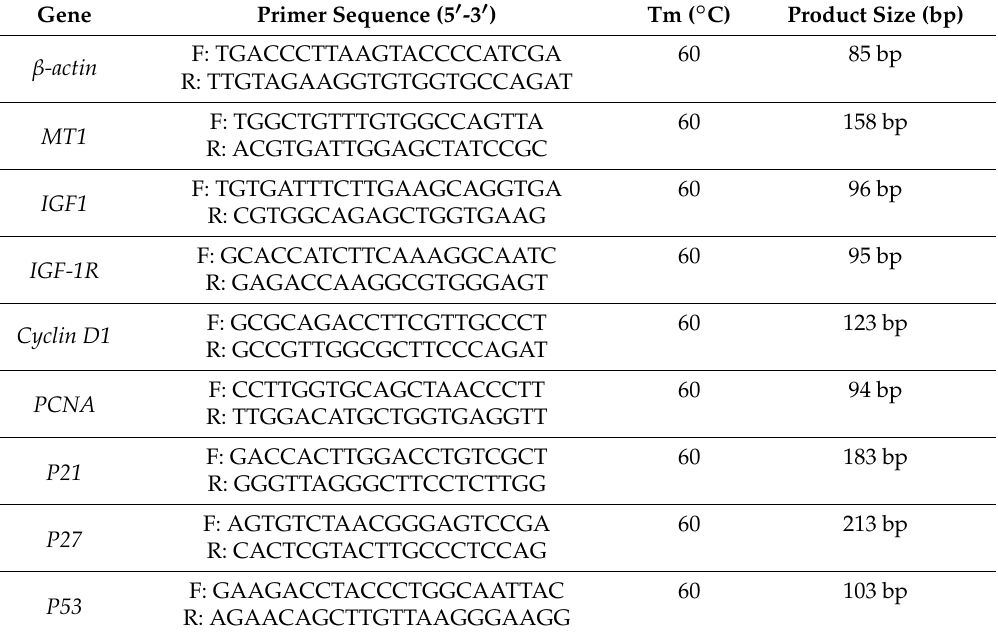
Table 2. Primers used in this study for real-time